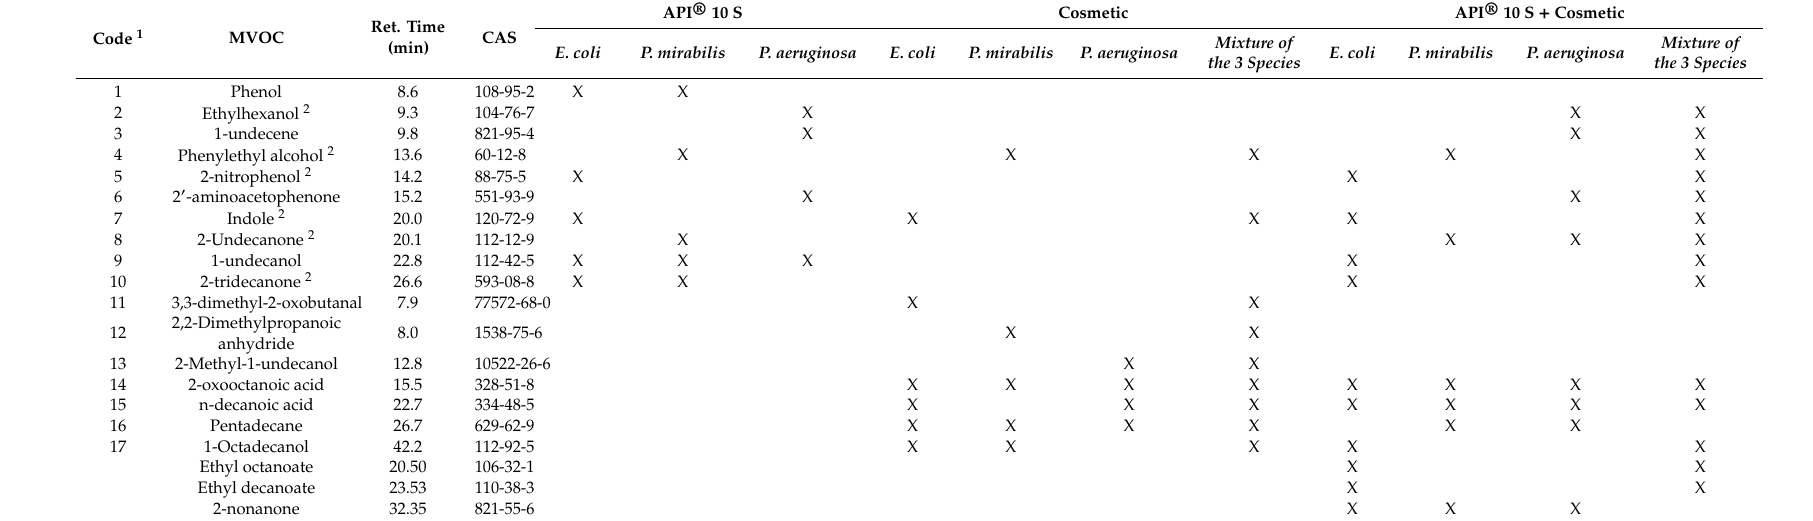
Table 2. Identified MVOCs by SPME-GC-MS generated by the studied microorganisms from inoculated API ® 10 S, cosmetic, and both substrates. Code